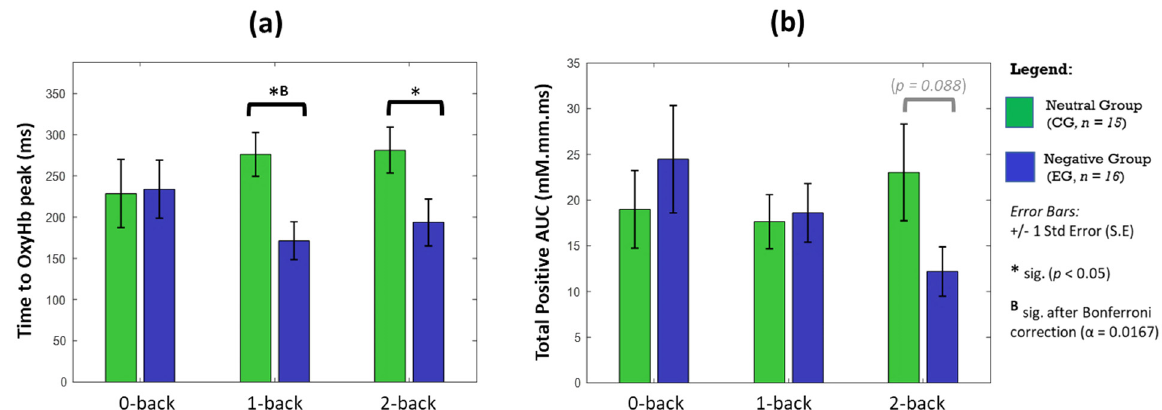
Figure 5. OxyHb temporal properties of significant activated channels in LRPFC during n-back tasks. We plotted the OxyHb signal’s ( a ) time taken to the highest peak from task onset, and ( b ) the total area under the curve (AUC) where OxyHb > baseline zero for each affective state and WML. Statistical analysis performed between CG and EG using an independent U -test (2-tailed), with significant * p < 0.05 without multiple-hypothesis test correction and ( B ) indicates Bonferroni–Holms correction applied ( α < 0.0167). Error bars indicate standard error (S.E).